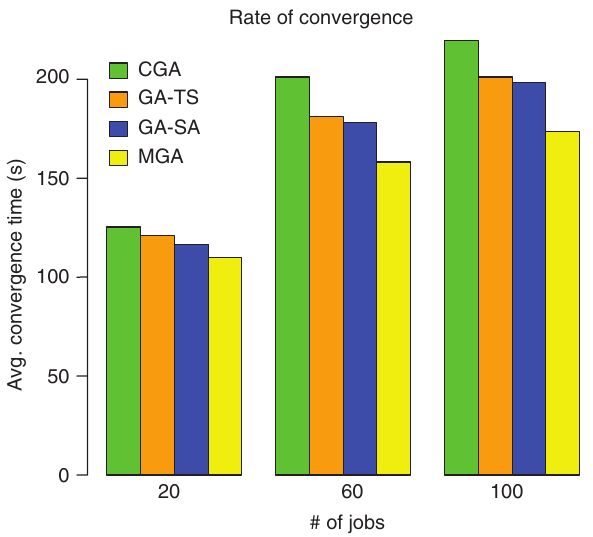
Figure 5: Average Convergence Time for Four Search